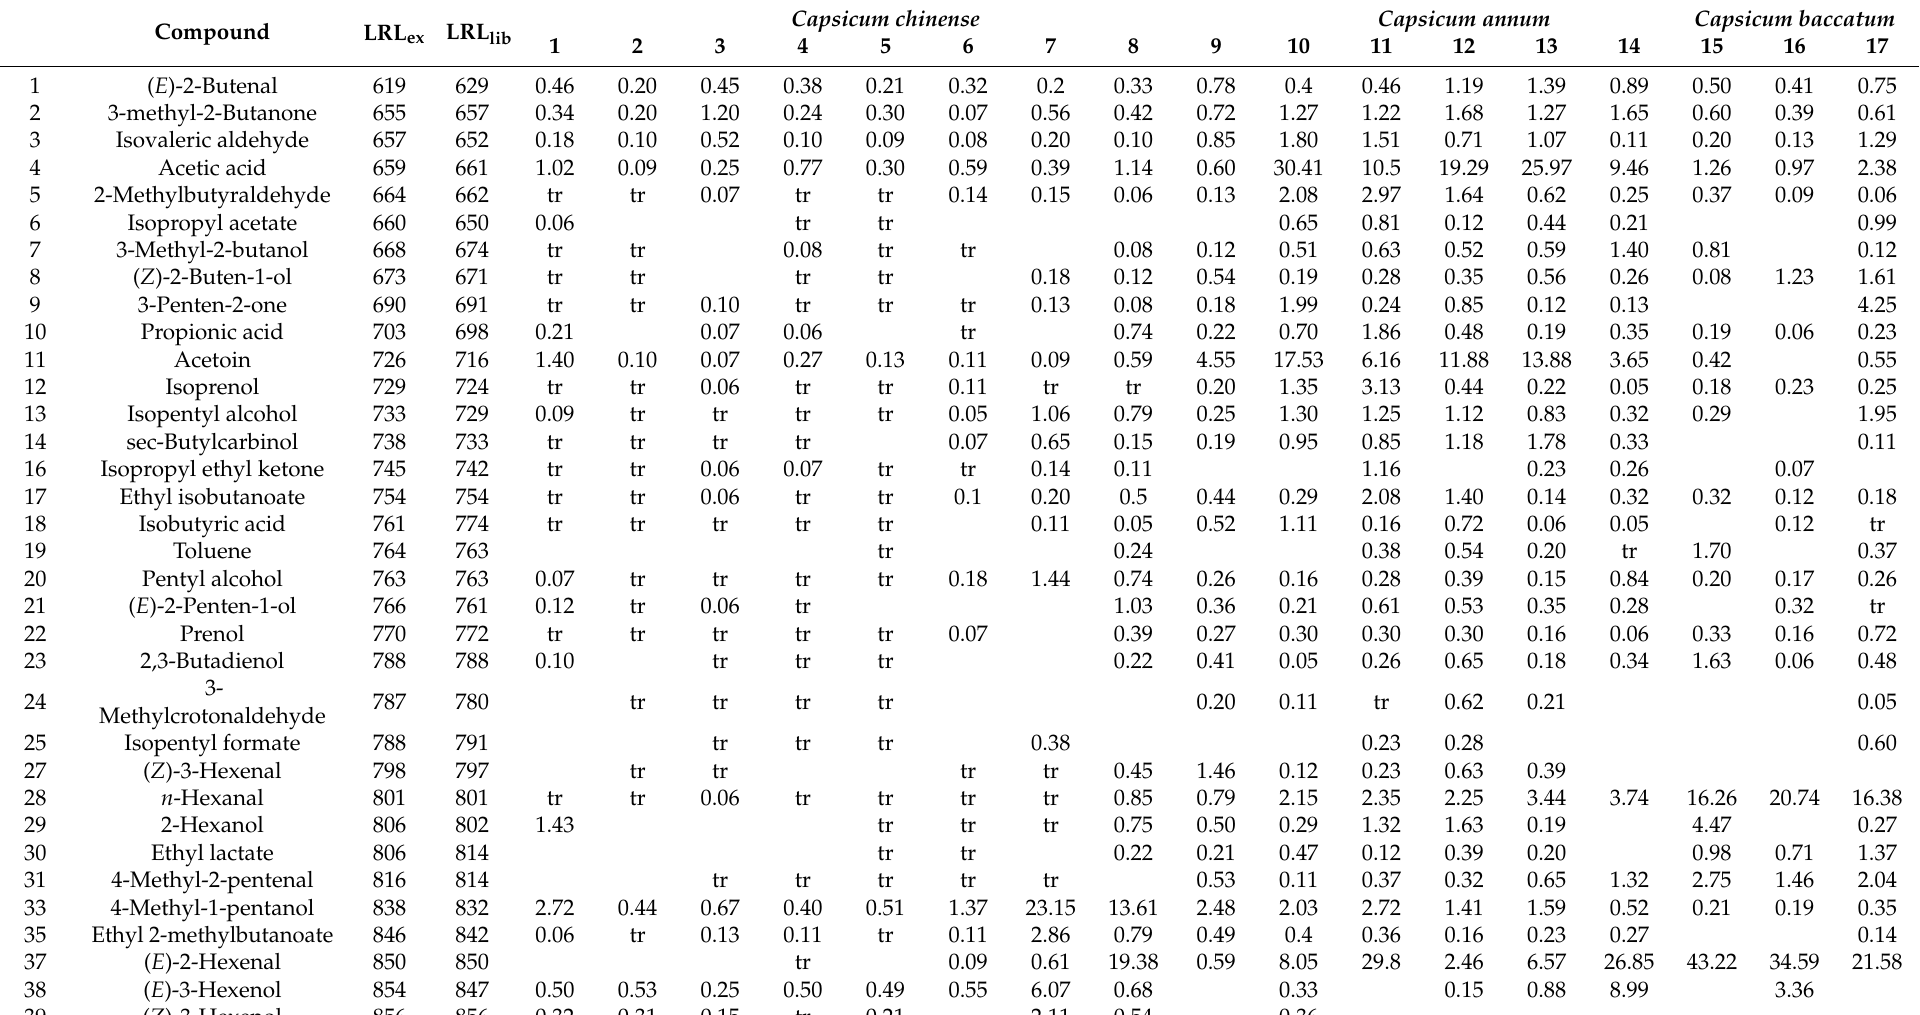
Table 2. Most abundant volatile compounds contained in the chili peppers samples analyzed expressed in area % as GC-FID